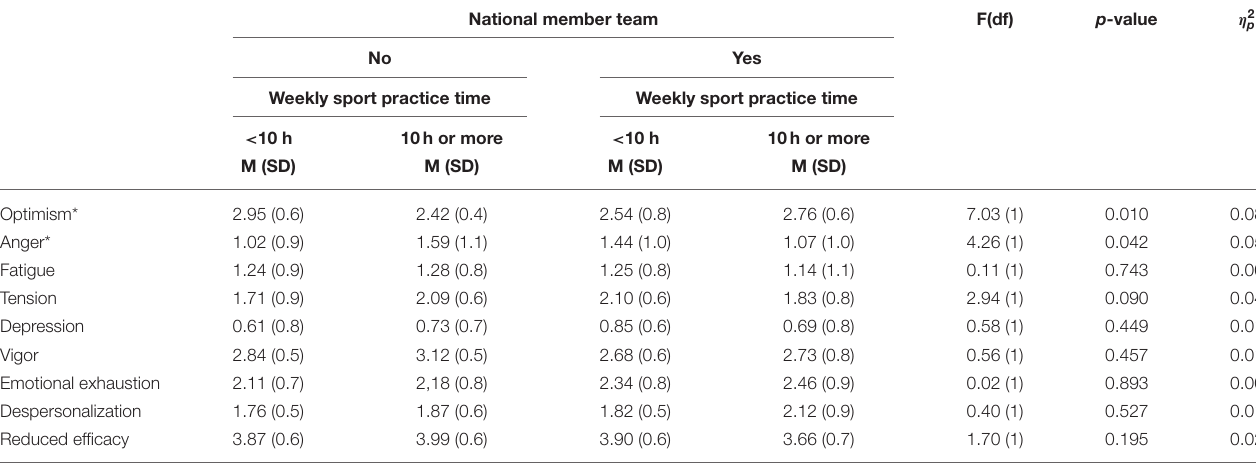
TABLE 5 | MANOVA analysis of the variables by weekly practice time and national member